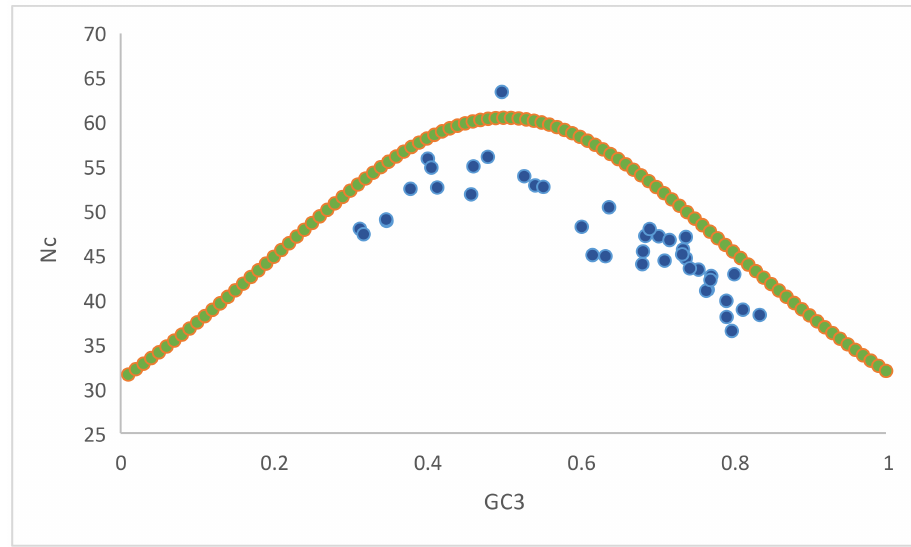
Figure 10. Nc-GC3 curve for determining the compositional constrain selection pressure and muta- tional